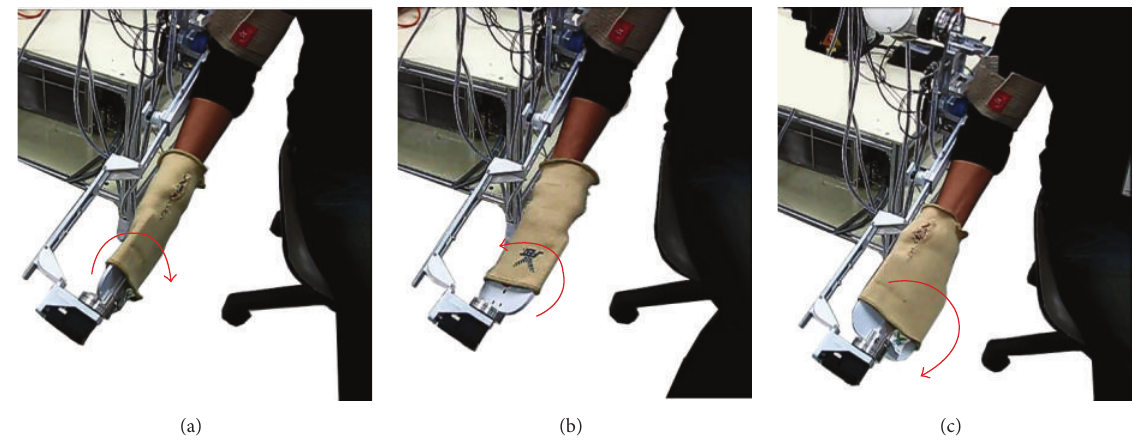
Figure 12: Example movements of SEFRE Rehab System: forearm pronation-supination.